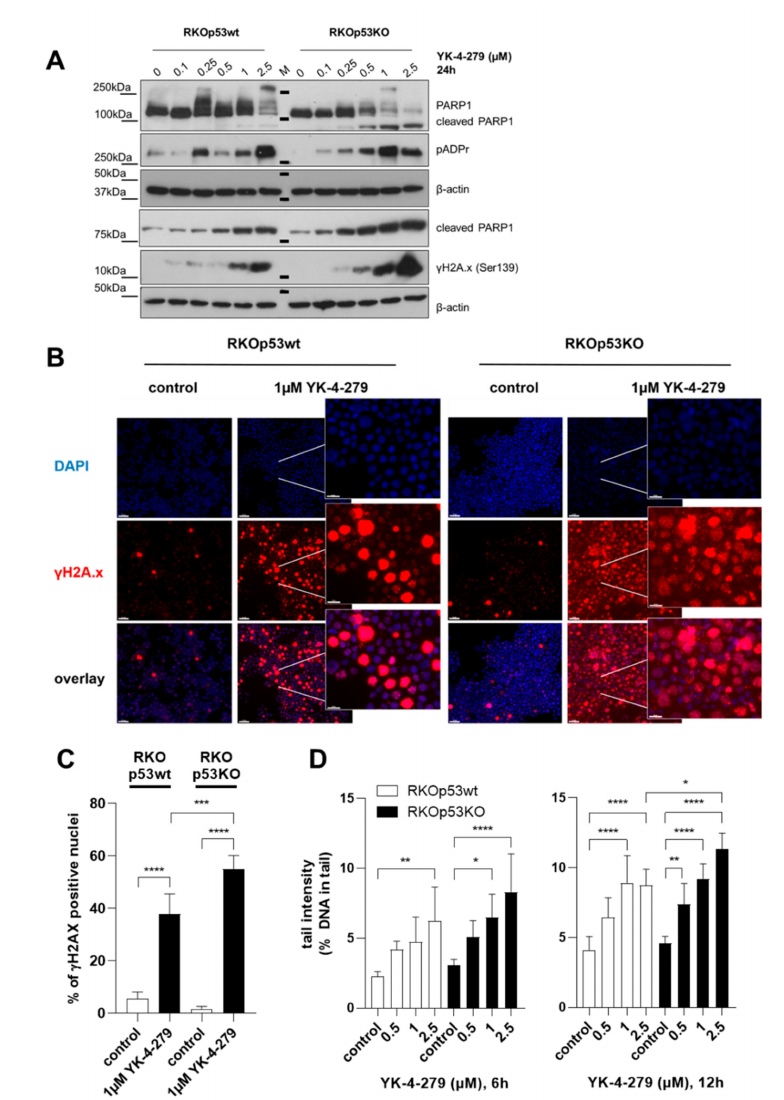
Figure 4. Association between the p53 status and PARylation of PARP1 as well as induction of DNA damage by YK-4-279. ( A ) Effect of YK-4-279 treatment (24 h) at the indicated concentrations on PARylation (indicated by pADPr) of PARP1 as compared to the levels of full-length PARP1, cleaved PARP1 and γ H2A.x analyzed in RKOp53wt and RKOp53KO cells by Western blot. β -actin served as loading control. ( B ) Subcellular localization of γ H2A.x (red) in the indicated cell models upon 24-h YK-4-279 exposure was determined by immunofluorescence staining. DAPI (blue) was used as DNA counterstain. Representative fluorescence photomicrographs are shown. The scale bar indicates 50 µ m (overview) and 20 µ m in the zoom-in inserts. ( C ) Quantification of the experiment under ( B ) was performed with whole-slide scanning technology (Pannoramic Digital Slide Scanner) and evaluation of at least eight regions of interest with Definiens Tissue Studio ® Software. Percentage of γ